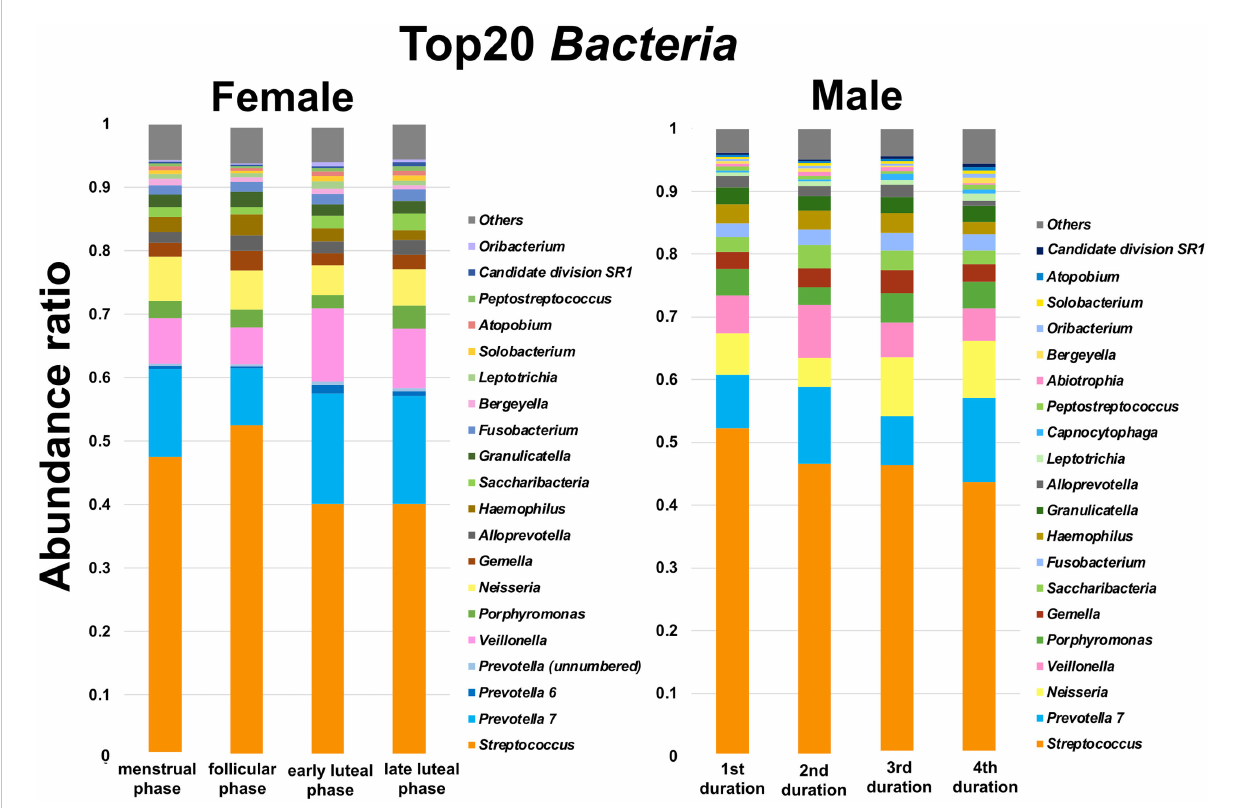
FIGURE 1 Abundance ratios of the top 20 bacteria genera in the oral microbiome. Stacked bar plots showing the composition of the most dominant genera color-coded and ranked according to abundance, while Prevotella 6 and Prevotella unnumbered genera were arranged next to Prevotella 7 genus. The abundance ratios in females are shown in four phases: menstrual, follicular, early luteal, and late luteal phases. The abundance ratios in males are shown with four durations corresponding to the number of days: days 1 – 2, 1 st duration; day 14, 2 nd duration; days 21 – 22, 3 rd duration; day